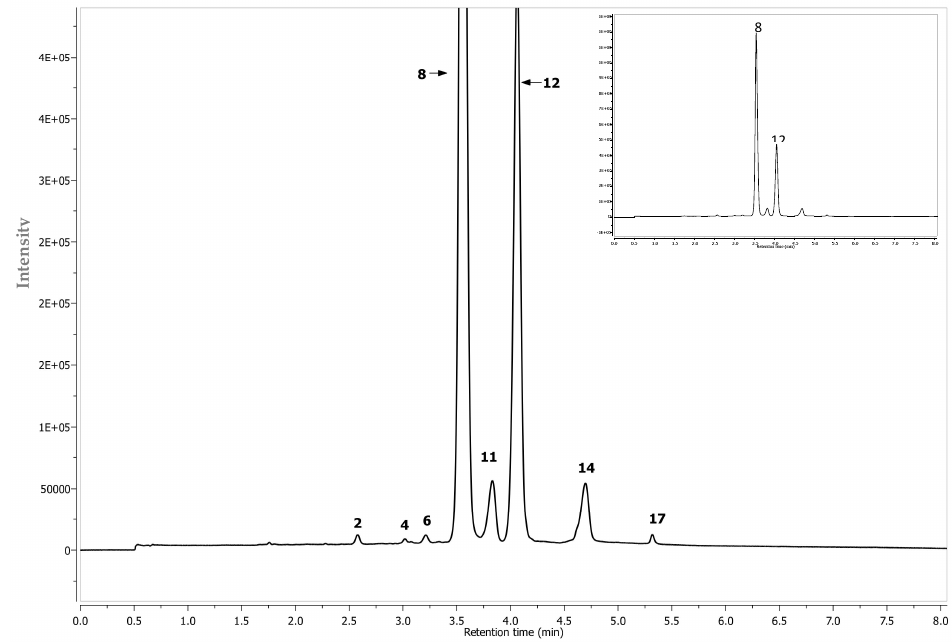
Figure 6. Segment from 0.0 to 8.0 min of LC-DAD chromatogram at 520 nm of chokeberry extracts. Peak number identities are displayed in Table 2.